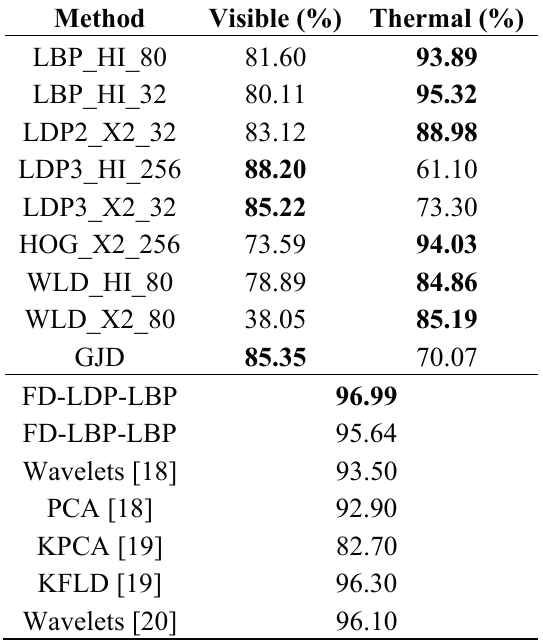
Table 2. Average recognition rate for the proposed fusion method against all face recognition methods for the Equinox database. Results in bold show the best variation. HI, histogram intersection; WLD, Weber law descriptor; GJD, Gabor jet descriptor; KPCA, kernel PCA; KFLD, kernel Fisher linear